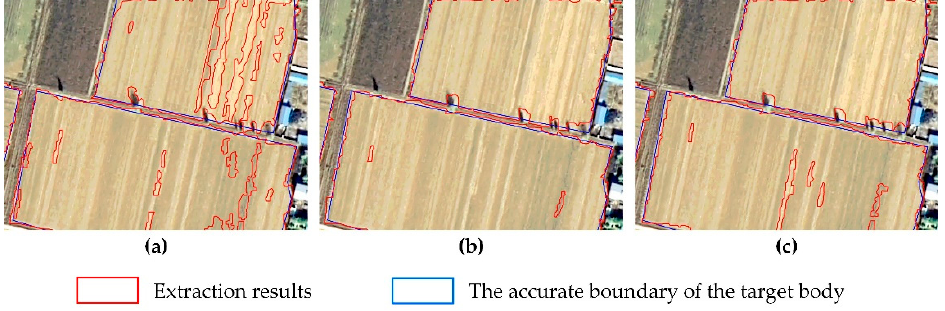
Figure 9. Comparison of the optimal extracted cultivated land boundary using the three methods: ( a ) RGB-RMWS; ( b ) Lab-RMWS; ( c ) Luv-RMWS. ( a ) RGB-RMWS; ( b ) Lab-RMWS; ( c )